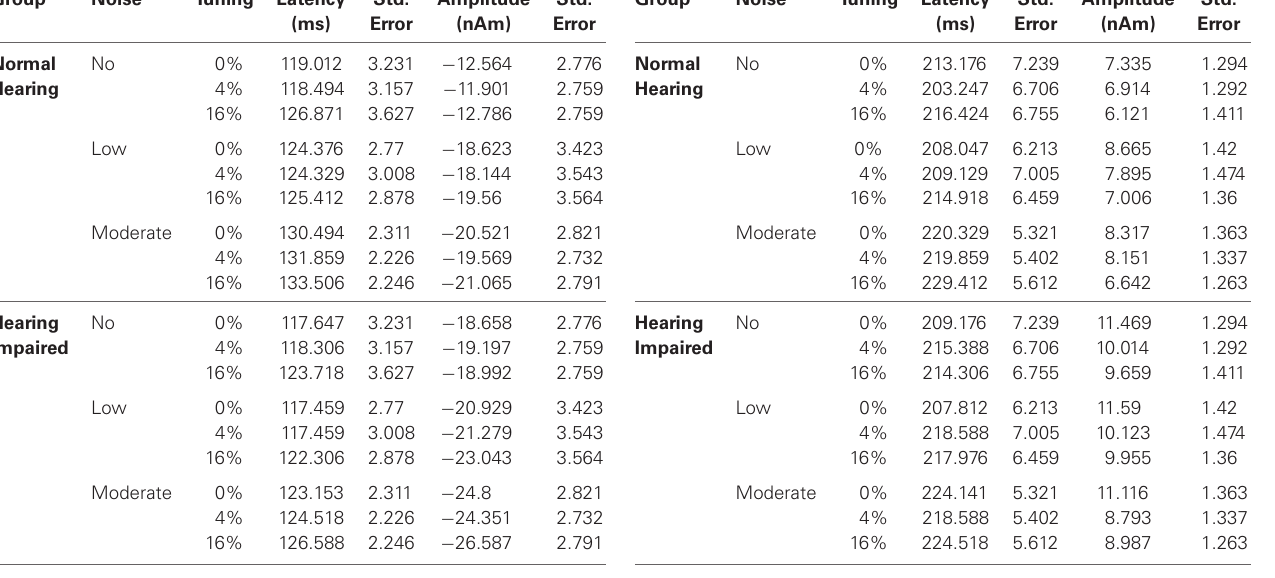
Table 3 | Group mean P2m latency and amplitude . Group Noise Tuning Latency